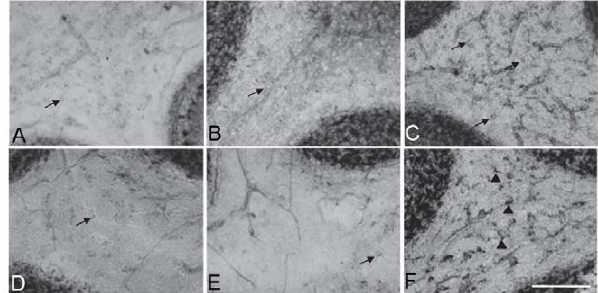
Figure 3. NADPH-d labeling in the cerebellar white matter (at the vermis region - 0.5 mm mediolateral distance) during development. A, B and C - P9; D, E and F - P23. A e D (NM); B and E (SHAM); C and F (HI). Observe that NADPH-d staining shows a higher number of cells (shown here in black - arrows) in HI animals, when compared to NM and SHAM ones. Observe in F that the morphology of the positive cells (arrowheads) in P23 HI animal is different from the NADPH-d stained cells in NM/SHAM animals at the same age and from all groups at P9. Calibration bar: 50 m m.